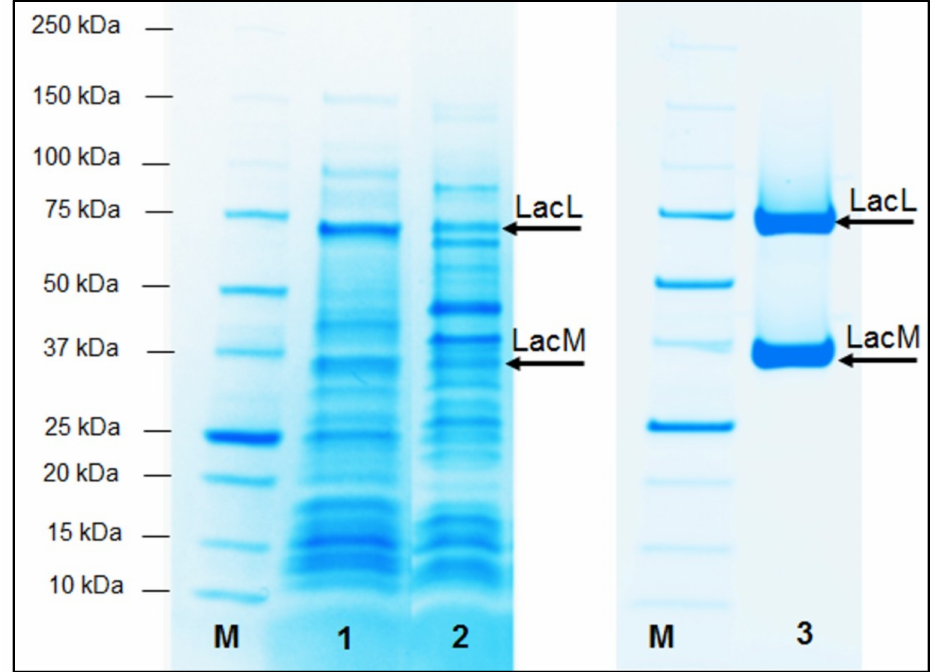
Figure 3. SDS-PAGE analysis of crude and purified β -galactosidase ( lacLM ) from L. helveticus DSM 20075 overexpressed in E. coli BL21 Star (DE3) and L. plantarum WCFS1. Lane 1, whole-cell lysates of E. coli BL21 Star (DE3) carrying the plasmid pET21lacLMLh with 1 mM isopropyl- β - D -thiogalactopyranoside (IPTG) induction at 25 ◦ C for 18 h; lane 2, whole-cell lysates of L. plantarum WCFS1 containing p409lacLMLh with 25 ng/mL inducing peptide pheromone IP-673 at 30 ◦ C for 8 h; lane 3, purified recombinant β -galactosidase EcoliBL21Lh β -gal. The arrows indicate the LacL and LacM subunits of the recombinant β -galactosidase. M denotes the Precision protein ladder (Biorad, CA,